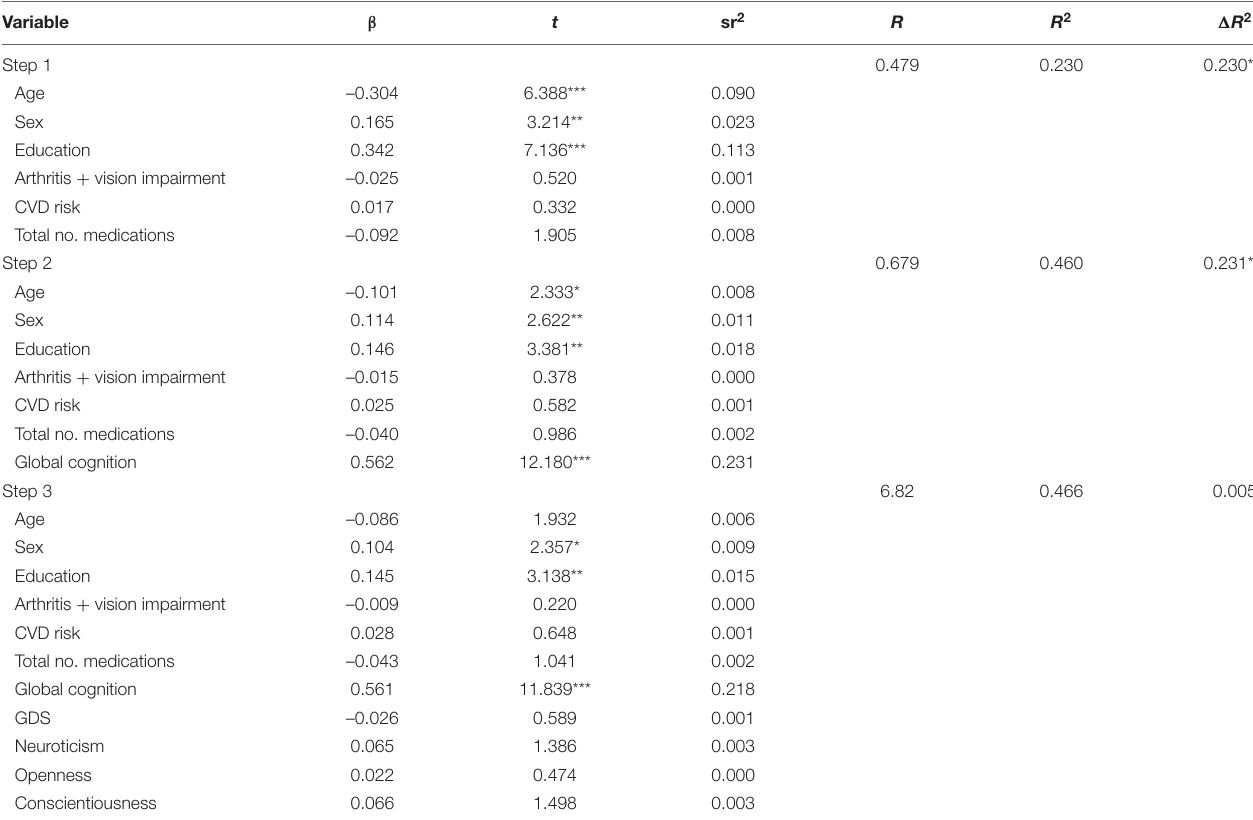
TABLE 4 | Hierarchical linear regression predicting performance-based